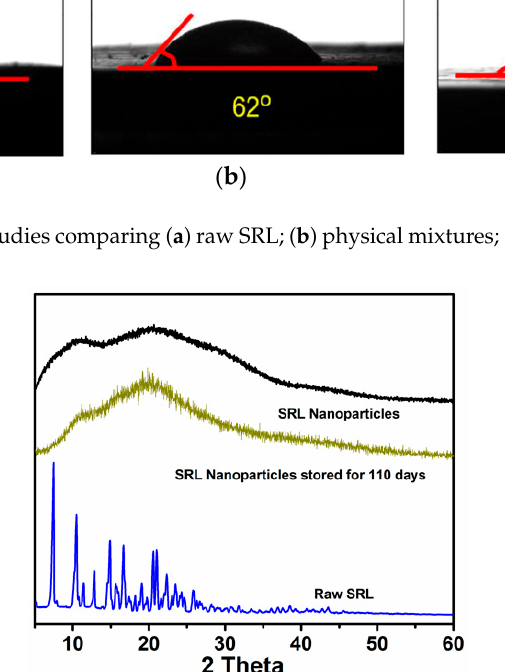
Figure 7. XRD patterns of raw SRL, SRL nanoparticles, and SRL nanoparticles stored for 110 days.